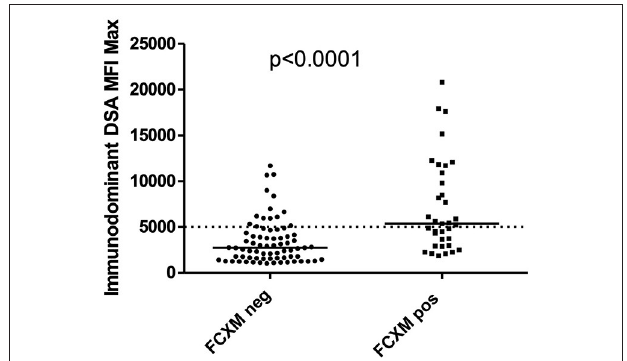
FIGURE 3 | Patients with FCXM positive have significantly higher immunodominant DSA MFI compared to patients with FCXM negative. Nevertheless, 14 out of 73 (20%) of FXCM negative and 19 out of 35 (54%) patients with FCXM positive had immunodominant donor-specific antibody mean fluorescence intensity (DSA MFI) > 5,000, 5 out of 35 (14%) patients with FCXM positive had immunodominant DSA MFI < 2,500.